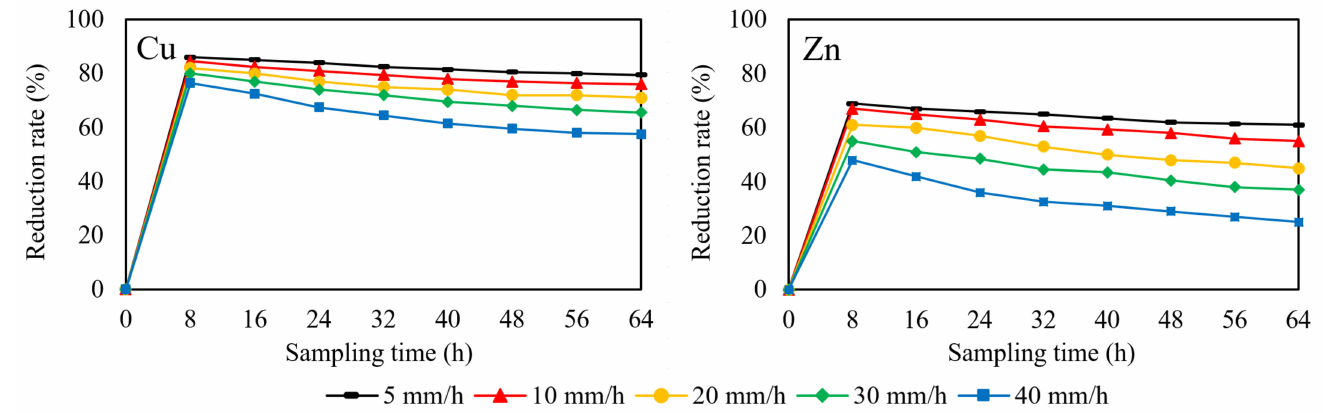
Figure 6. Reduction rate of copper and zinc at different rainfall